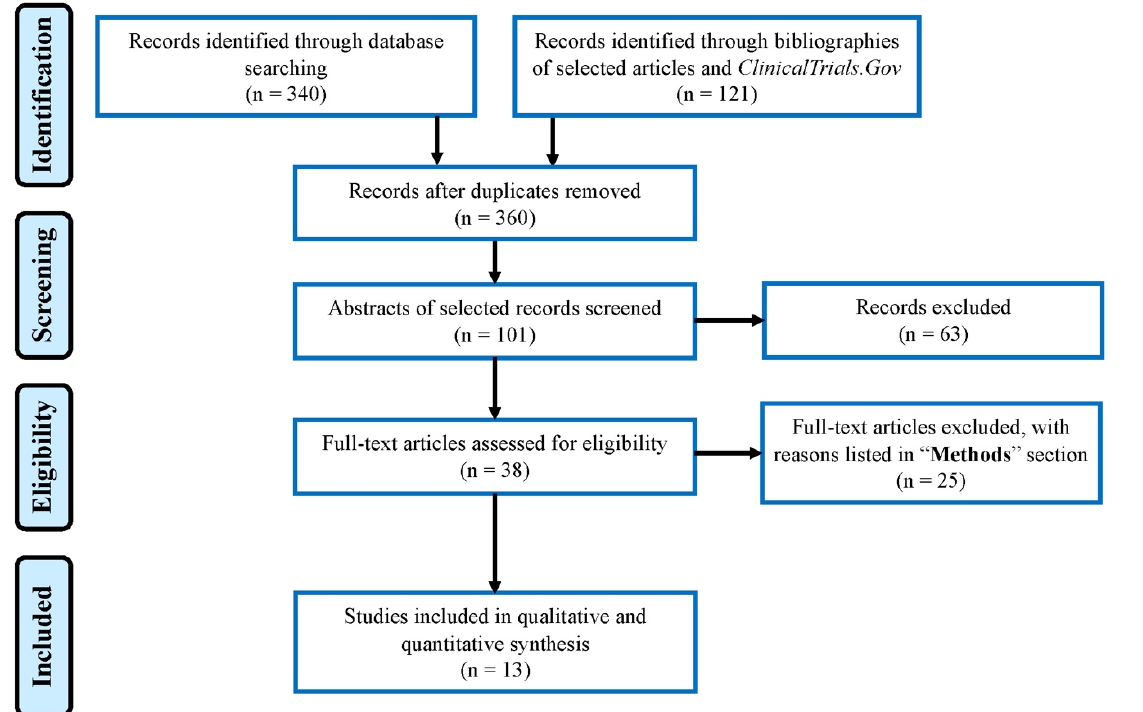
Figure 3. PRISMA flow chart of the systematic review.